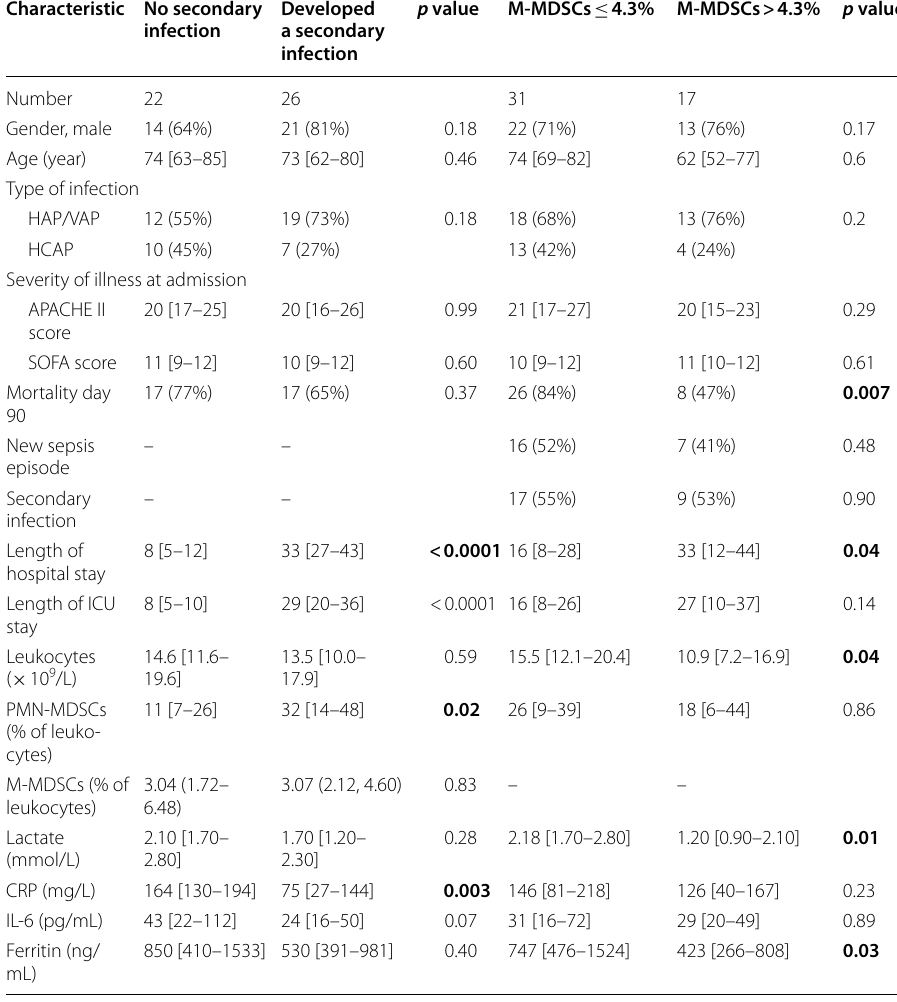
Table 2 Characteristics of patients grouped according to the occurrence of secondary infection